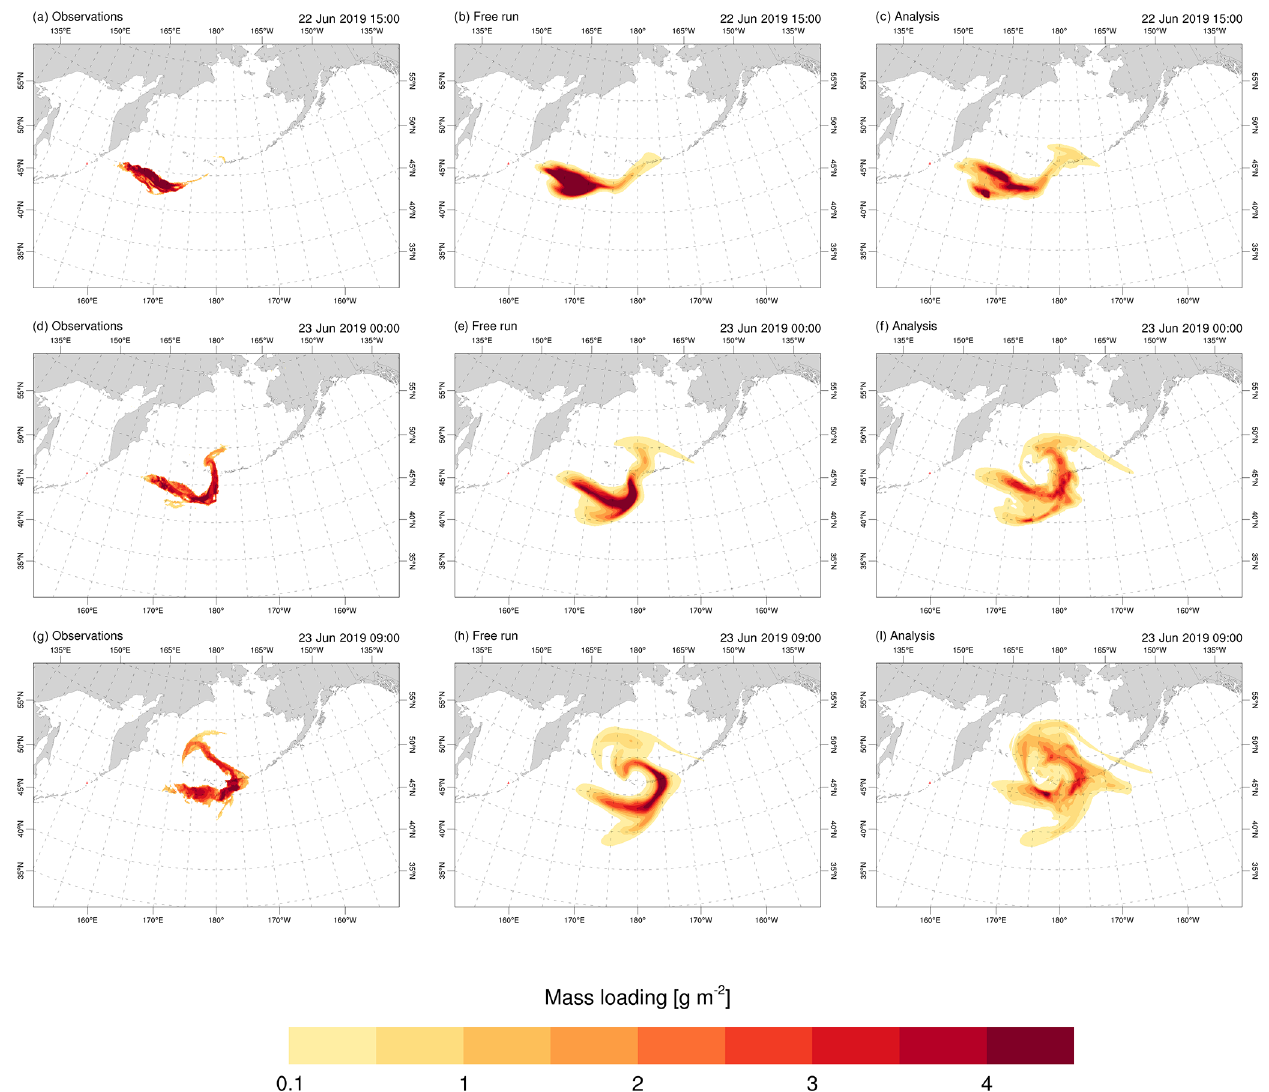
Figure 7. Spatial distribution of SO 2 mass loading at different time instants: (a–c) 22 June at 15:00UTC, (d–f) 23 June at 00:00UTC and (g–i) 23 June at 09:00UTC. The column panels show observations (left panel), free run (central panel) and analysed mass loading (right panel). Panels in the central and right columns correspond to ensemble